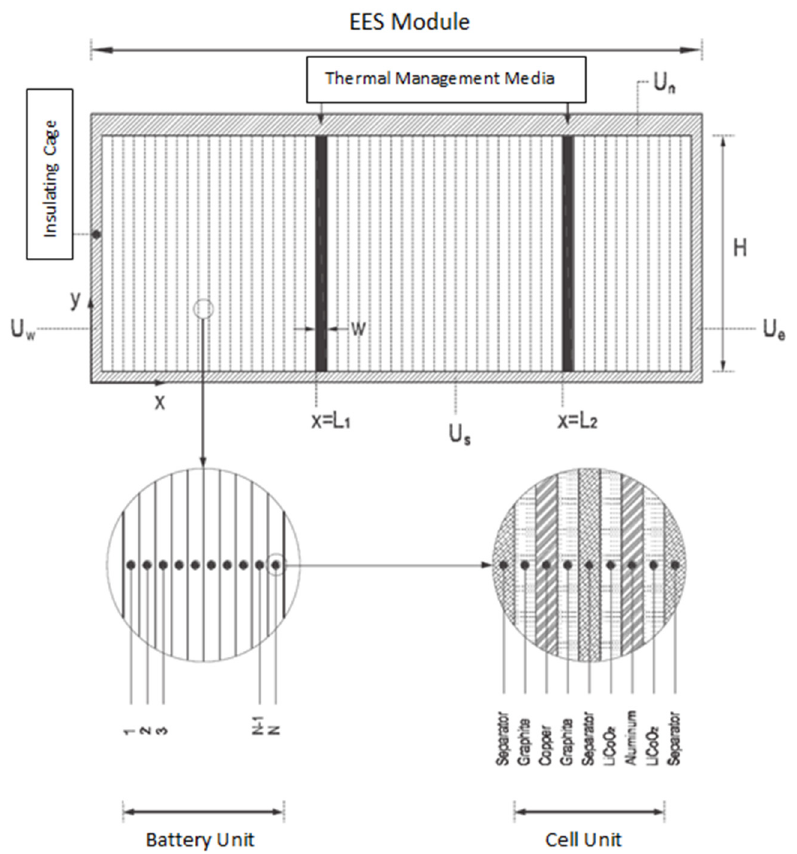
Figure 2. Schematic of Li-ion battery used in finite element analysis model